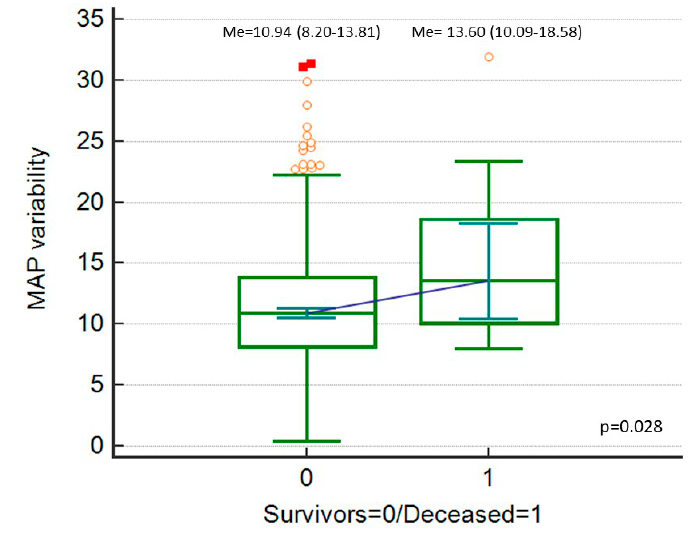
Figure 4. Mean blood pressure (MAP) variability (expressed as MAP_Cv in %), comparison between deceased patients and survivors.